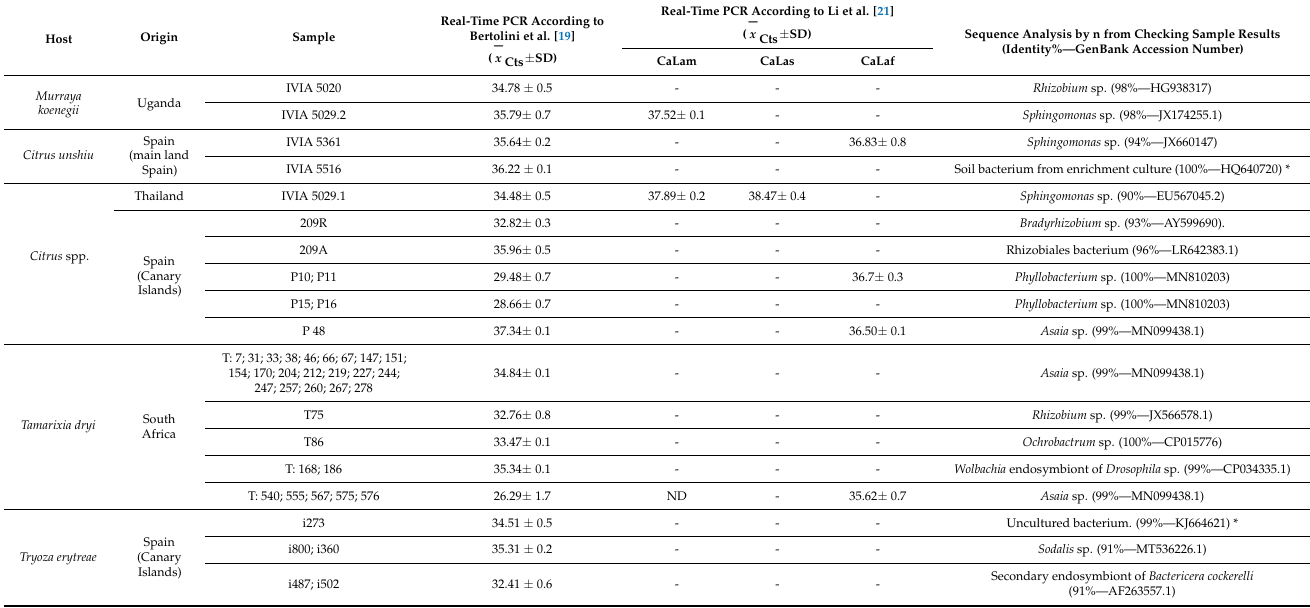
Table 2. Highest sequence identity at the nucleotide level in the GeneBank database of the samples positive by PCR protocols of Bertolini et al. [19] or Li et al.